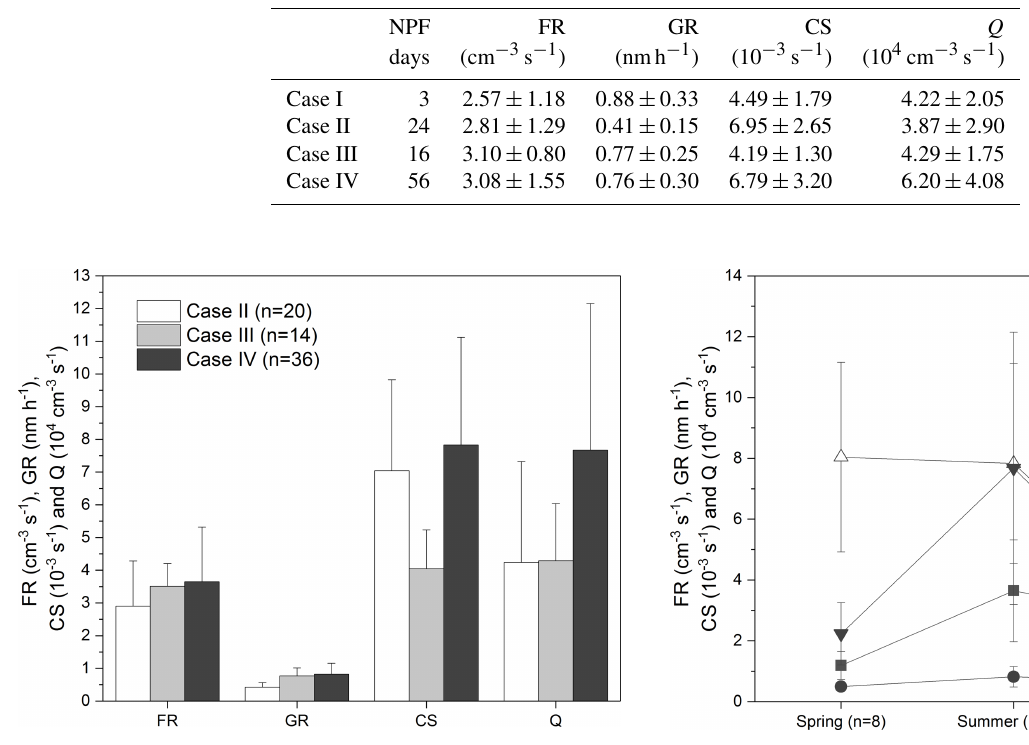
Figure 7. Seasonal characteristics of parameters related to NPF events in which the air masses originated from the Bellingshausen Sea. FR, GR, CS and Q refer to formation rate, growth rate, conden- sation sink and source rate of condensing vapor, respectively. The error bars represent standard